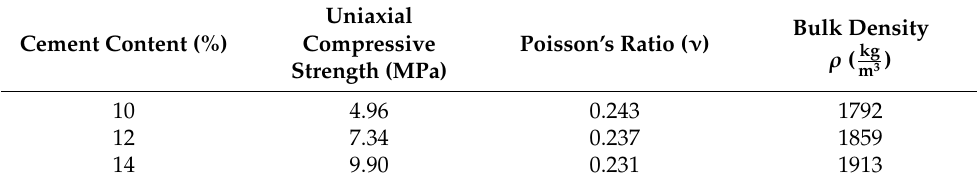
Table 1. Mechanical properties of the synthetic specimens .